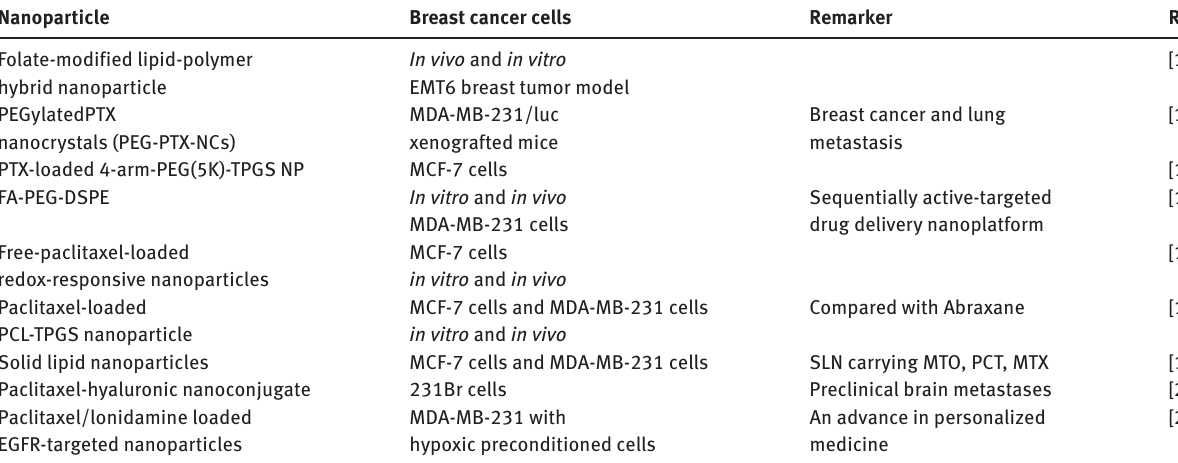
Table 1: Representative nanoparticles for treatment of breast cancer.